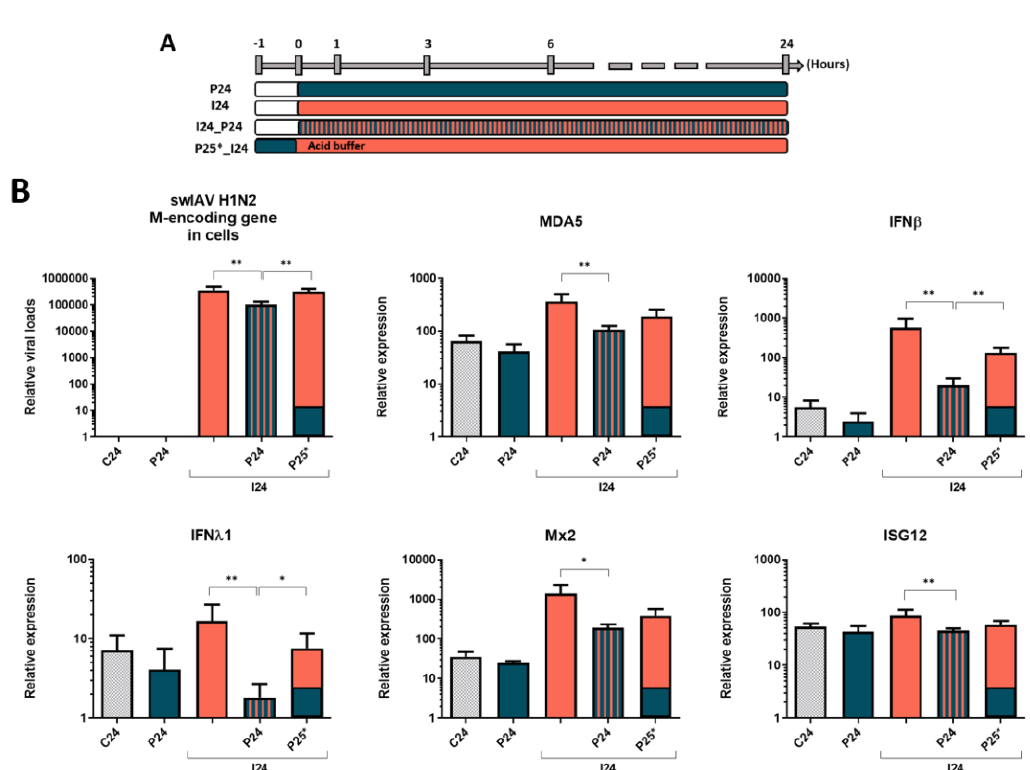
Figure 3. Protocol ( A ) and relative viral loads and relative expression of cellular transcripts ( B ) showing the impact of the inactivation of non-penetrated PRRSV-1 particles by the acid bu ff er wash on swIAV H1N2 replication and NPTr cells response. Cells were infected at an MOI of 3, n = 6 wells per condition for qPCR. C24 stands for the non-infected condition over 24 h, P24 stands for PRRSV-1 stimulation over 24 h, I24 for swIAV H1N2 infection over 24 h, I24_P24 for the coincubation of both viruses over 24 h, and P25*_I24 for the stimulation with PRRSV-1 for 1 h then infection with swIAV H1N2 for 24 h after an acid bu ff er wash. Mean values and standard deviations are represented. Comparisons were carried out using a one-way ANOVA test and Tukey’s post-test. Di ff erences were considered significant when p < 0.05 (*) or p < 0.01